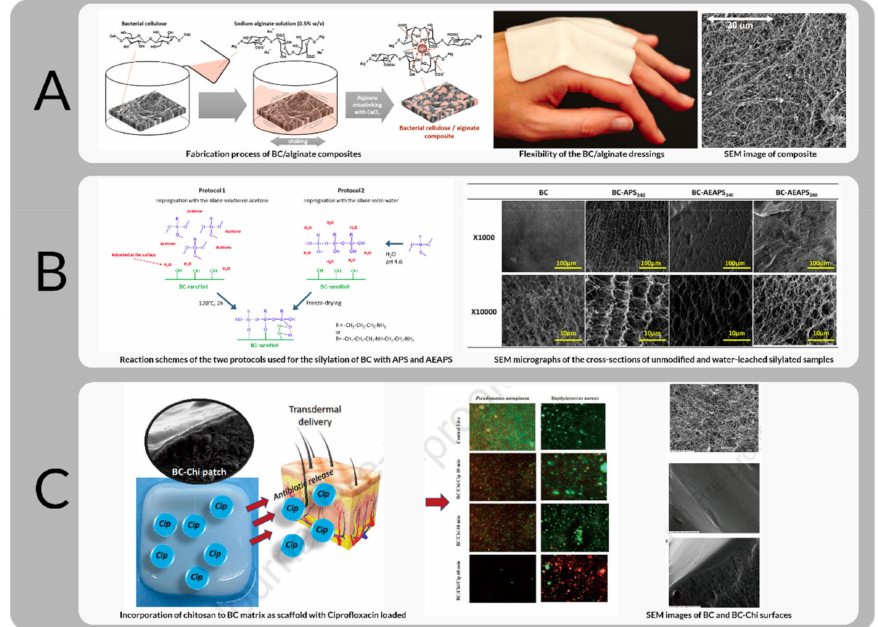
Figure 11. Images adapted from key studies using the ex-situ (ExSUP) modification method. ( A ) Fabrication of BC/alginate composites, image of final membrane and SEM image; adapted with permission from [172]. ( B ) Reaction schemes of the two protocols used for the silylation of BC with APS and AEAPS and SEM micrographs of composites; adapted with permission from [33]. ( C ) Chitosan-bacterial cellulose patch of ciprofloxacin for wound dressing, images observed with an epifluorescent microscope and SEM images; adapted with permission from